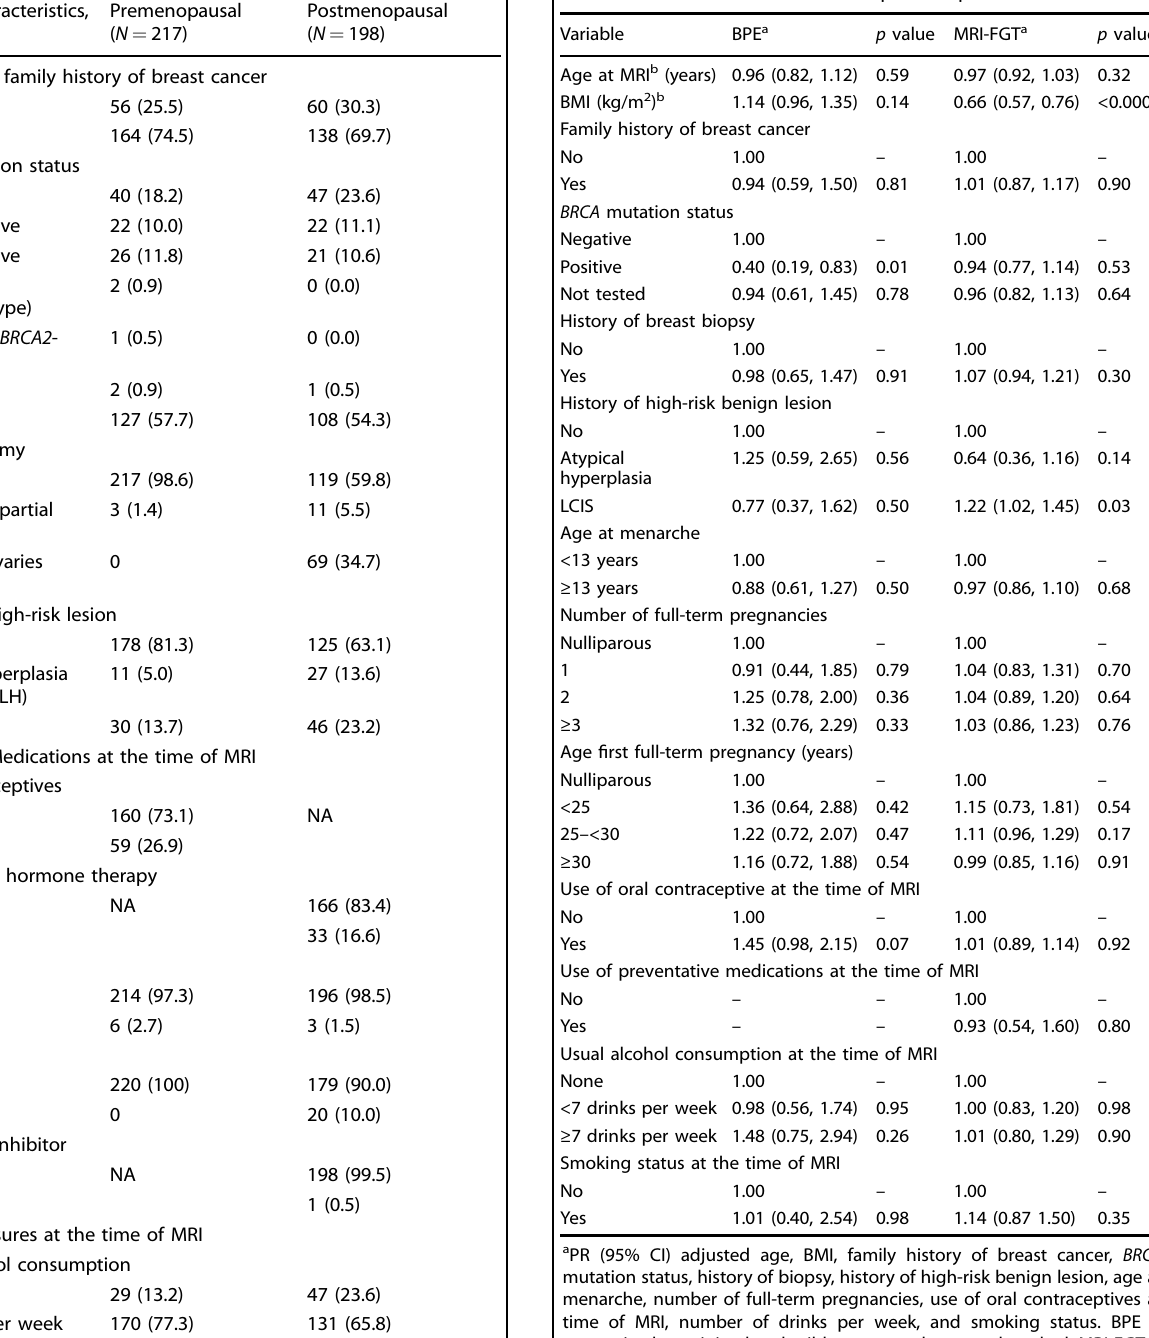
Table 4. Multivariable adjusted prevalence ratios (PR) and 95% con fi dence intervals (CI) for the relationship between breast cancer risk factors and BPE and MRI-FGT in premenopausal